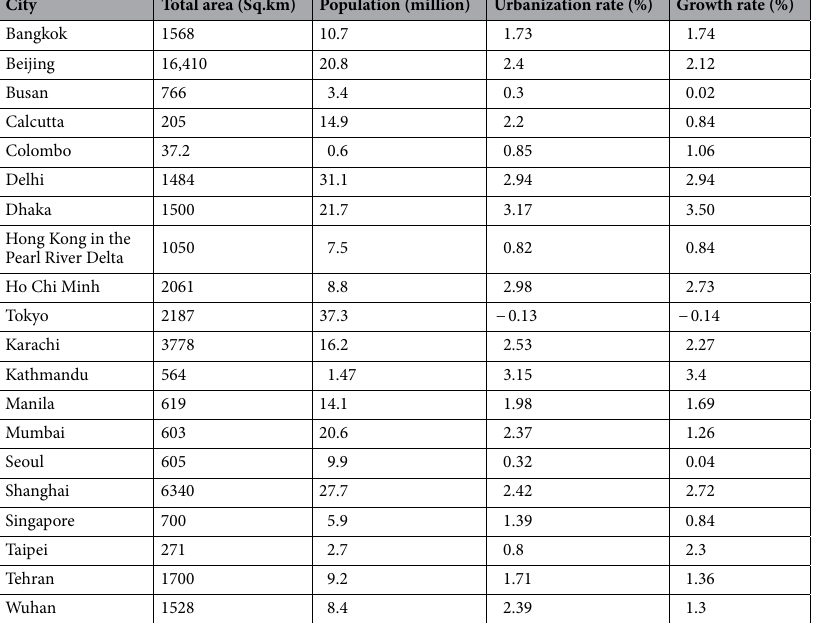
Table 1. Demographic characteristics of the selected cities 21